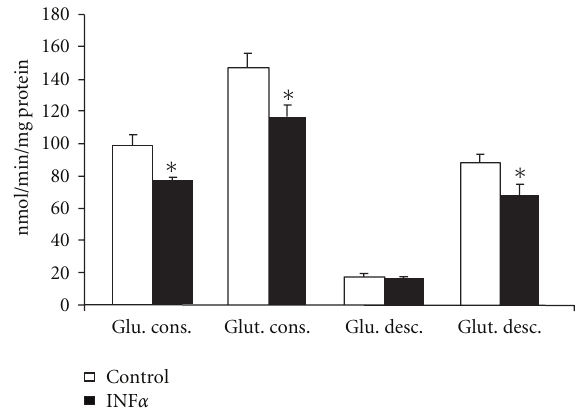
Figure 4: Consumption and decarboxylation of glucose and glutamine by lymphocytes from spleen cultured in the presence or absence of IFN α . The results are expressed as nmol/min per mg of protein and represent the mean ± SEM of 9 experiments. ∗ P < . 05 for comparison with the control (C)